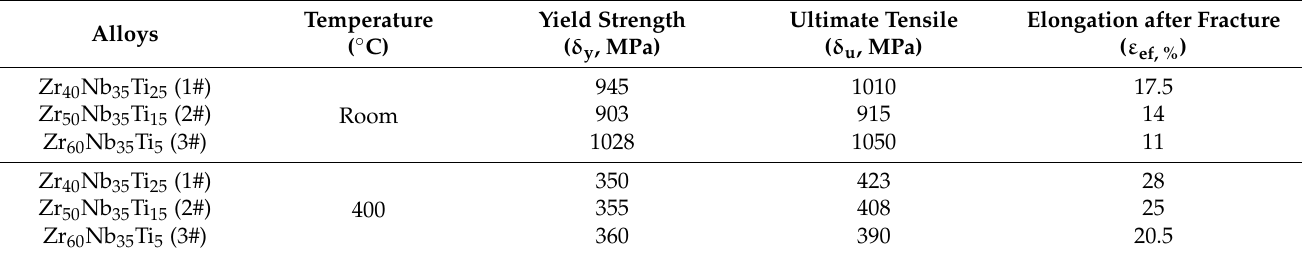
Figure 3. Engineering stress–strain curves of the alloys under tensile at ( a ) room temperature and ( b ) 400 °C. Table 4. The yield strength ( σ y ), ultimate tensile ( σ u ), and elongation after fracture ( ε ef ) for the ZrNbTi MEAs.